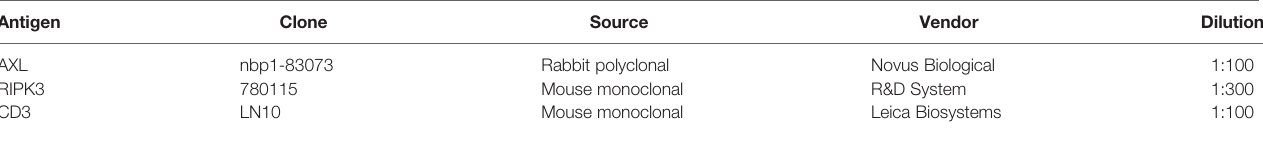
TABLE 1 | Antibodies used for immunohistochemistry.